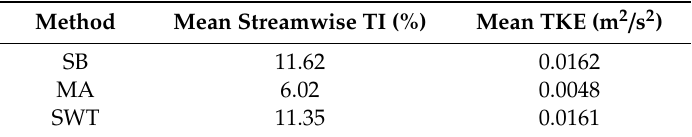
Table 5. Average turbulence intensity and total turbulent kinetic energy (TKE) from a 15-min long burst collected on the 26th April 2018 resulting from di ff erent wave-turbulence decomposition methods.